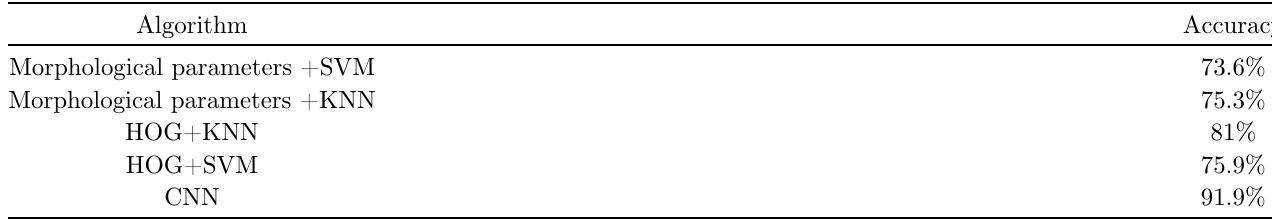
Table 7. The classi fi cation accuracy of test samples.